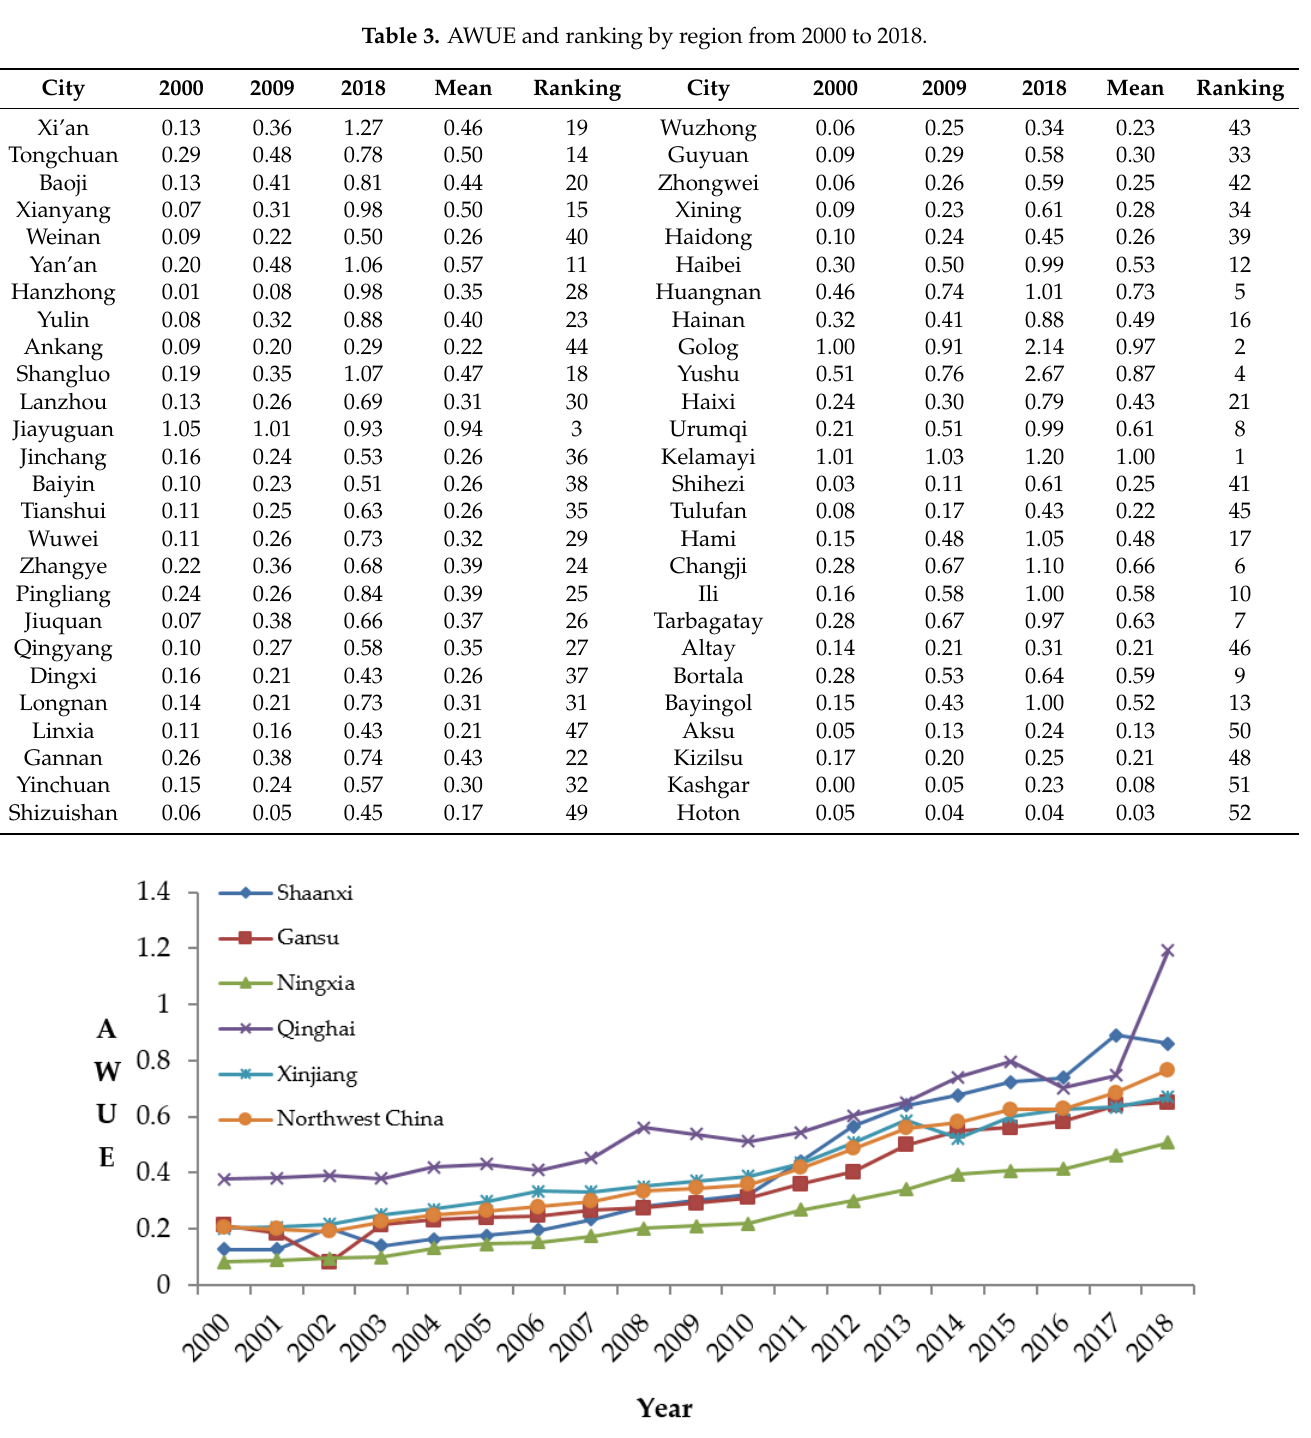
Figure 2. Evolution trend of agricultural water use efficiency (AWUE) in Northwest China from 2000 to 2018. From the overall perspective of Northwest China, by observing the trend of Figure 2, the AWUE showed a steady upward trend from 2000 to 2018. The average efficiency increased from 0.21 in 2000 to 0.77 in 2018, with an average growth rate of 3.11%. However, the average AWUE in each year is below 0.8, which is still far from the effective frontier, indicating that there is still large room for improvement in AWUE in Northwest